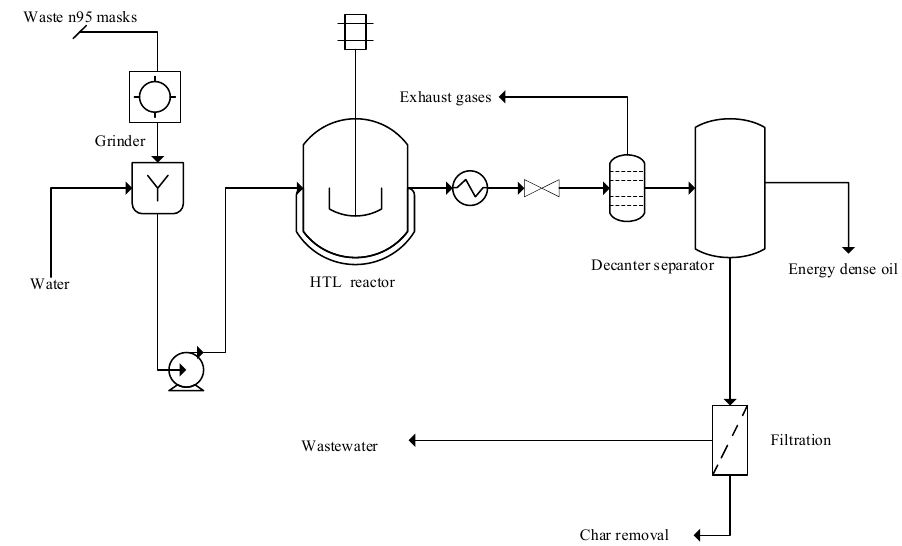
Figure 3. Waste N95 facemask conversion to an energy-dense (gasoline-like) oil product (scenario ii).